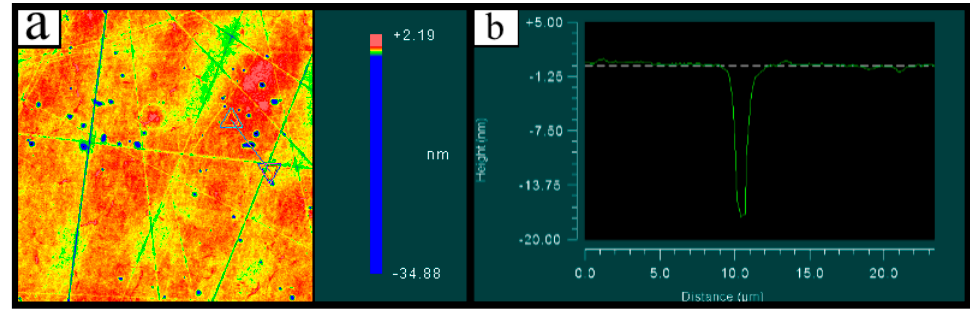
Figure 1. Surface profile of the studied ZGP samples, ( a ) color diagram of surface roughness, ( b ) deviations from the average roughness profile along the line (marked with triangles in ( a